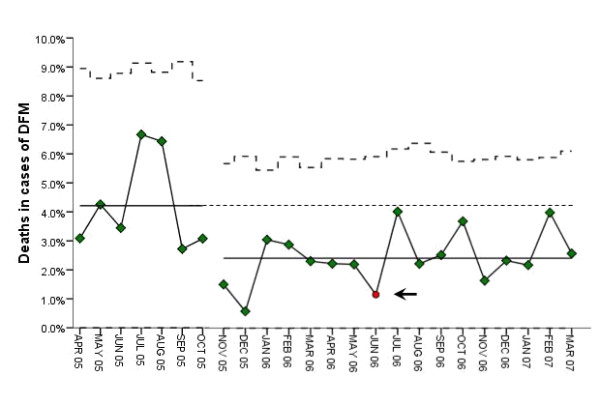
Stillbirth rates in pregnancies presenting decreased fetal movements. Statistical process control chart presenting the monthly stillbirth rates and means during the baseline quality assessment period and the intervention period. The arrow indicates the time (seventh month of intervention) at which a significant change was documented during the intervention.